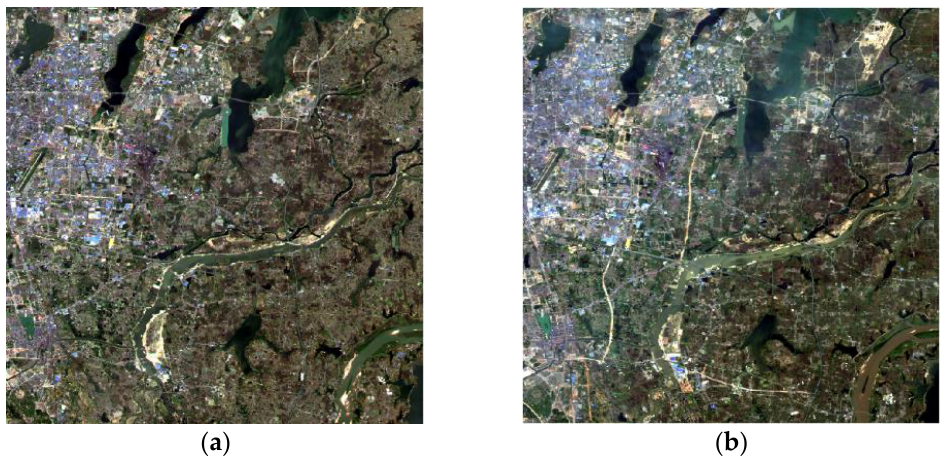
Figure 5. GF-1 wide field view (WFV) imagery of Nanchang Province: ( a ) 2015; ( b ) 2017.